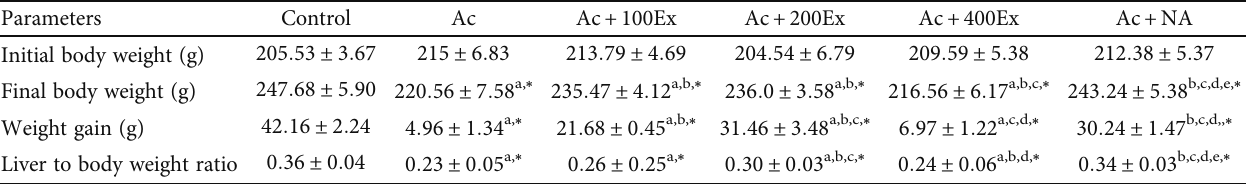
Table 1: Changes in initial weight, fi nal weight, and liver weight to body weight ratio in the animals of di ff erent groups. Parameters